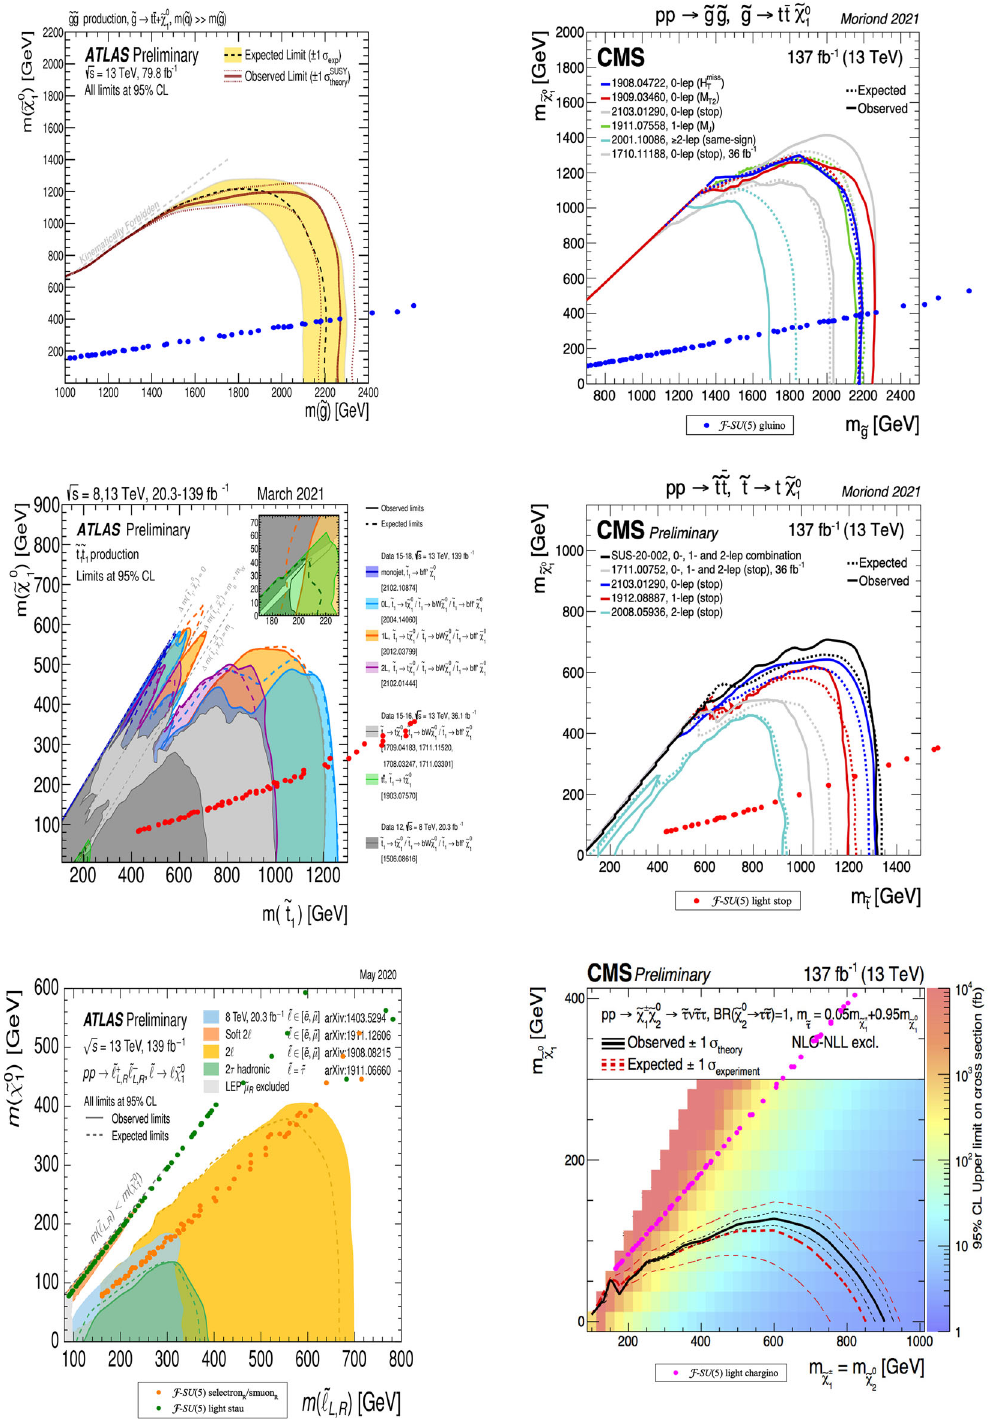
Fig. 3 Illustration of No-Scale F - SU ( 5 ) consistency with the most recent LHC constraints on gluino, light stop, slepton, and chargino masses. In this figure the model space is superimposed on top of the ATLAS [90–104] and CMS [105–115] exclusion plots. The model is represented by the small dots which are comprised of the prior bench- mark sets of Refs. [37–39,41–44]. The No-Scale F - SU ( 5 ) model space